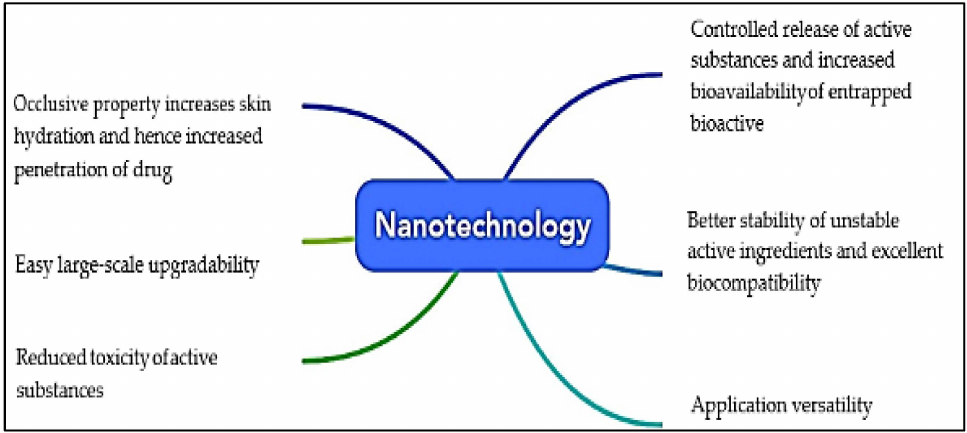
Figure 2. Benefits of nanotechnology in skincare products